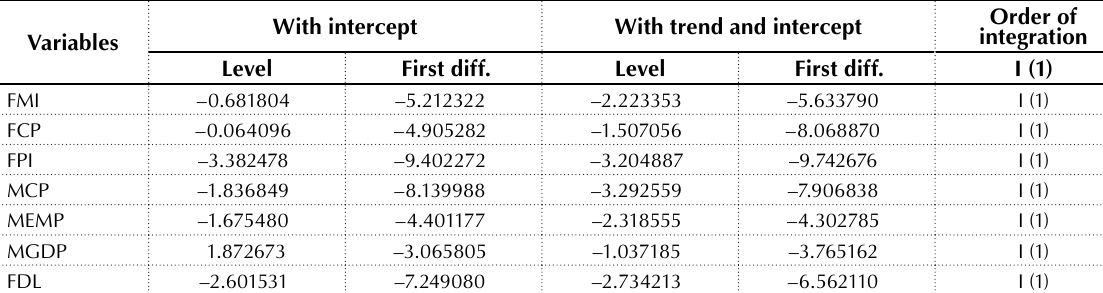
Table A2. Summary of PP unit root test of the series